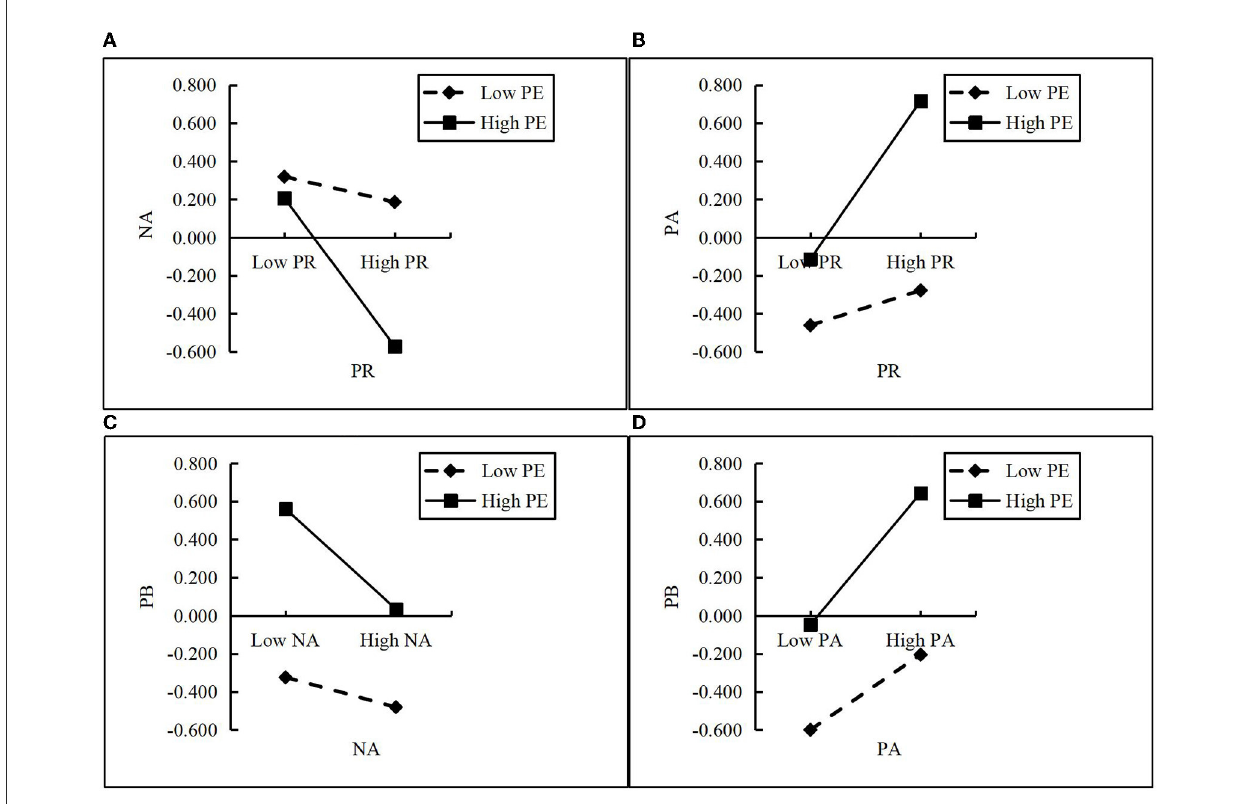
FIGURE2 Simple slope indicating the moderation effects. (A) Moderating effect of physical exercise on perceived risk and negative affect; (B) Moderating effect of physical exercise on perceived risk and positive affect; (C) Moderating effect of physical exercise on negative affect and preventive behavior; (D) Moderating effect of physical exercise on positive affect and preventive behavior. PR, perceived risk; NA, negative affect; PA, positive affect; PE, physical exercise; PB, preventive behavior.